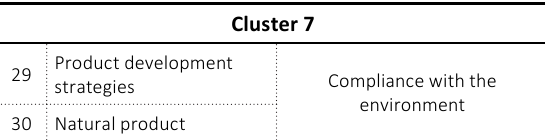
Table 8. Codes comprising Cluster 7